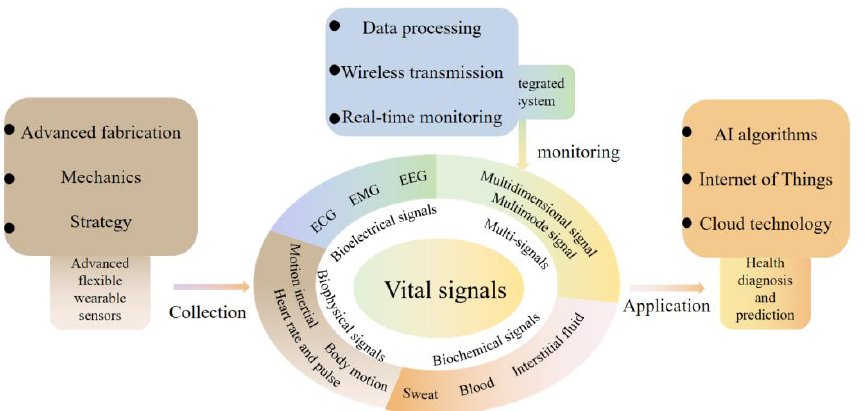
Figure 1. Processes for monitoring vital signals in health and exercise and an illustrated overview of this review. The article reviews each signal along the way process, including typical advanced wearable sensors, data acquisition and processing, and clinical and life applications.